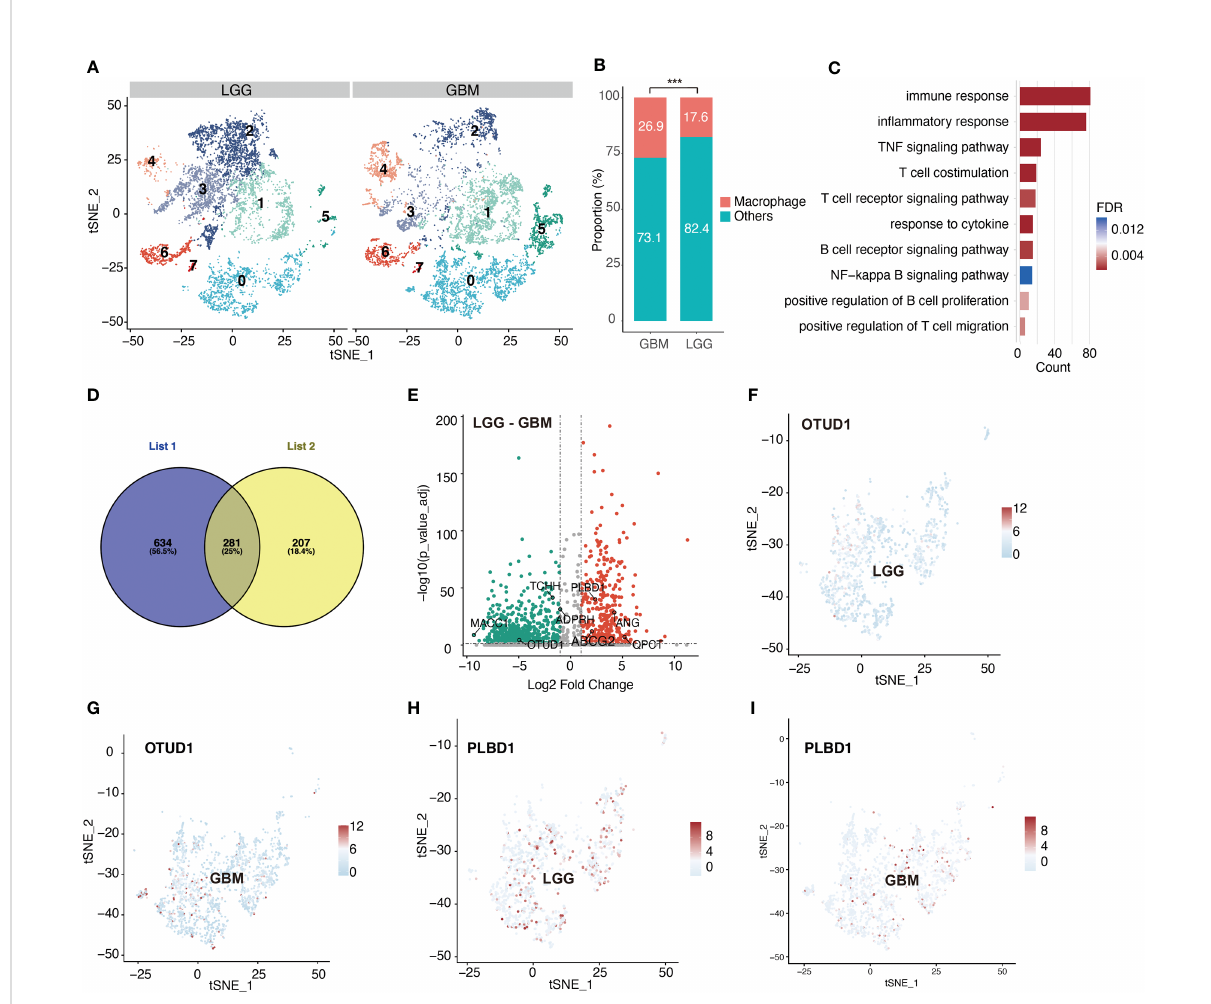
FIGURE 2 Signi fi cant differences emerge in macrophage clusters between LGG and GBM. (A) tSNE plot shows cell clusters of LGG and GBM. (B) Difference in the proportion of macrophage between LGG and GBM. (C) Difference in macrophage biological process between LGG and GBM based on gene enrichment analysis. (D) Venn diagram shows macrophage-related genes which are also differentially expressed between LGG and GBM. List1 shows the number of macrophage-related genes. List2 shows the number of differentially expressed genes in macrophage between LGG and GBM. (E) Volcano plot shows differentially expressed macrophage-related genes between LGG and GBM. (F – I) tSNE plots show the expression of the identi fi ed differentially expressed macrophage-related genes. ***P <